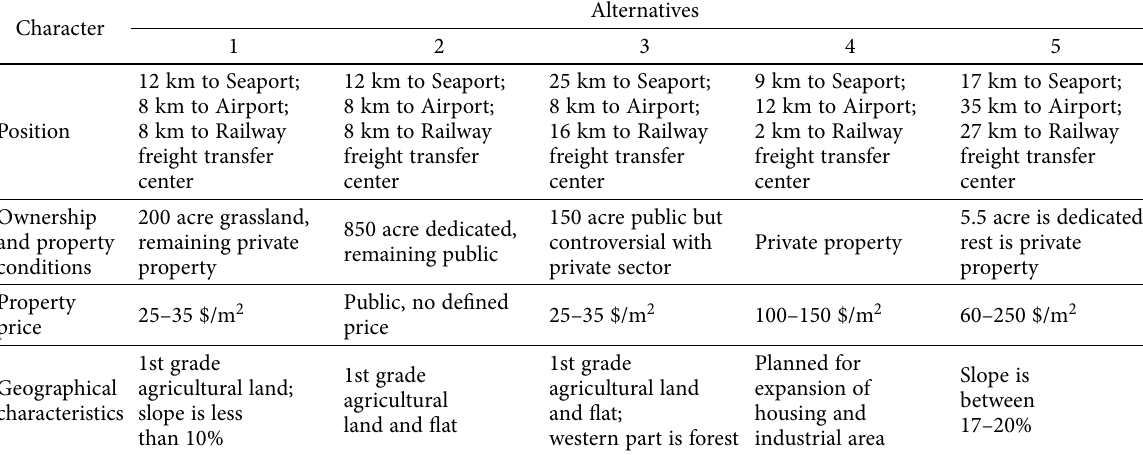
Table 1. Characteristics of potential areas for logistics